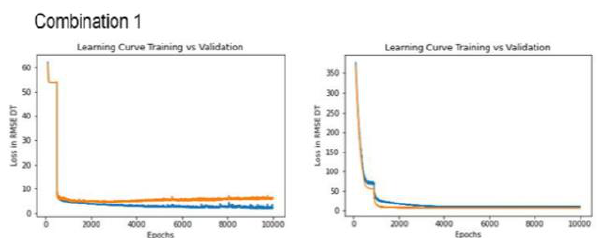
Fig. 8: Learning curves estimated vs reference max air temperature with LR=0.001 on the left and with LR=0.005 on the right- Combination 1 (left column loss in RMSE, right column epochs)